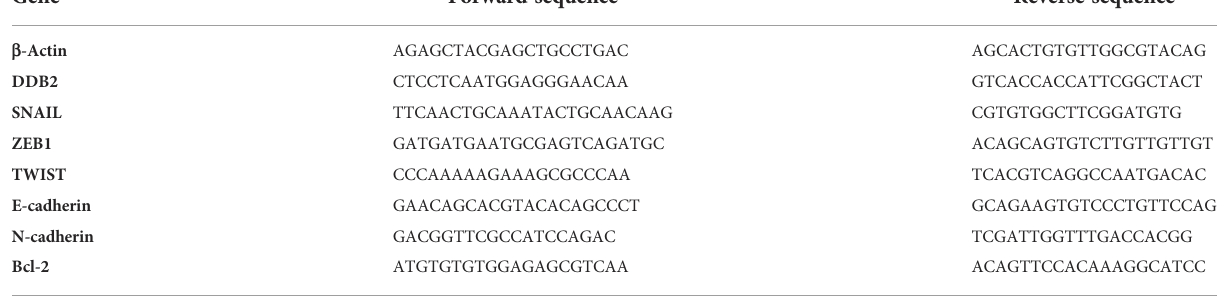
TABLE 1 Sequences of primers used for